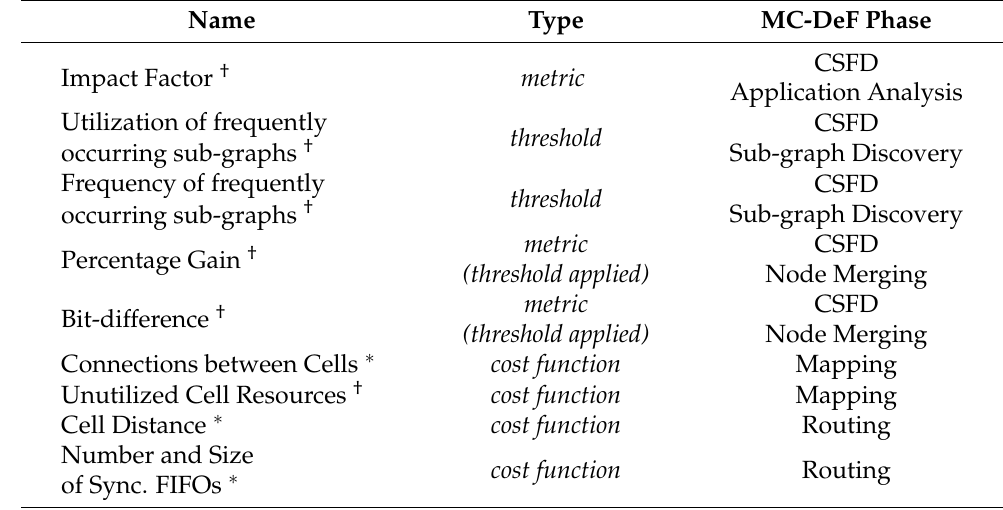
Table 5. MC-DeF metrics, thresholds and cost-functions. Entries annotated with ∗ are used for Communication infrastructure optimization, and with † for CGRA array